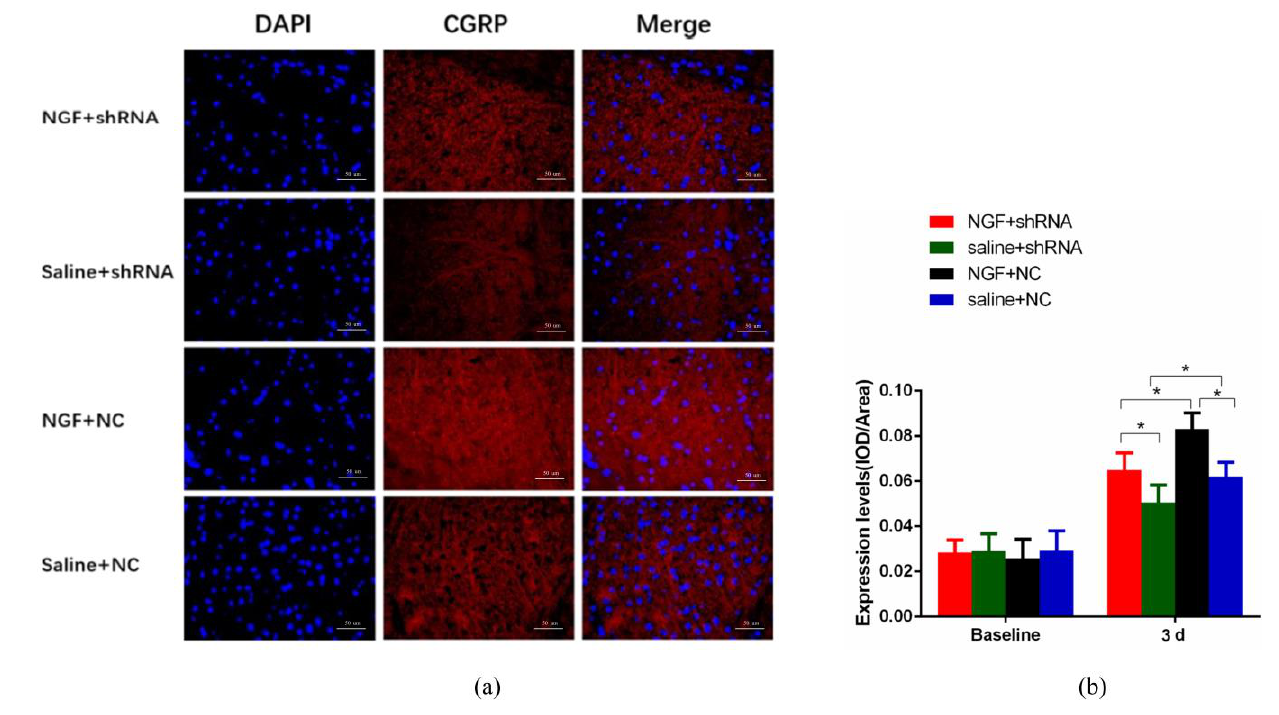
Figure 4. The expression of CGRP in Trigeminal Subnucleus Caudalis (Vc) for Saline + NC group, NGF + NC group, Saline + Atp6v0a1 shRNA group, and NGF + Atp6v0a1 shRNA group. ( a ) Immunofluorescence detection of CGRP expression in the superficial layer at 3d ( × 400). ( b ) The comparison of CGRP expression level among Saline + NC group, NGF + NC group, Saline + Atp6v0a1 shRNA group, and NGF + Atp6v0a1 shRNA group (Data are presented as mean ± SD, n = 6. *: p < 0.05).